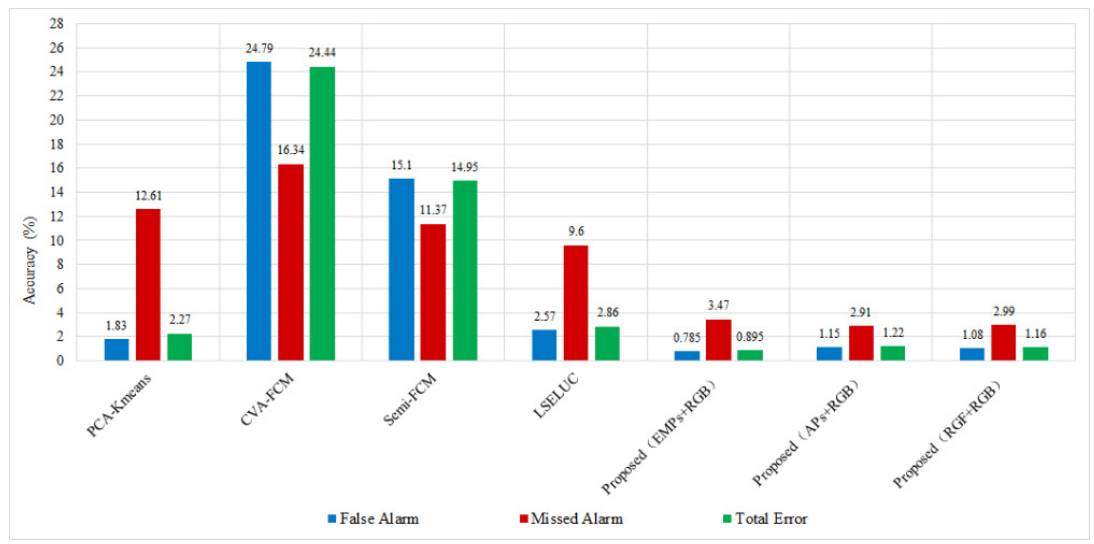
Figure 5. A comparison of the bar charts for the Site B landslide detection VHR remote sensing images.